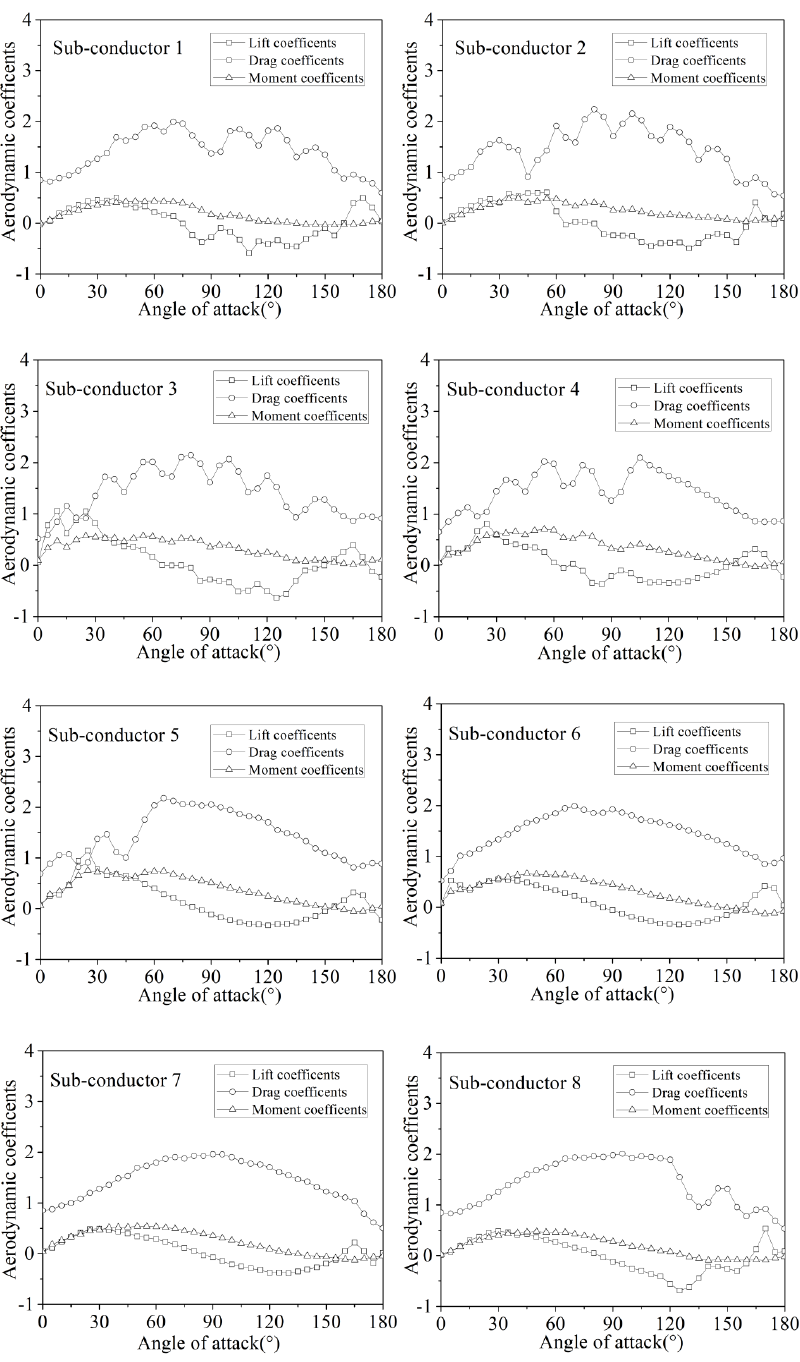
Figure 3. Aerodynamic coefficients of sub-conductors with crescent-shaped ice varying with angle of wind attack (ice thickness: 12 mm). 5. Galloping Characteristics of Conductors of Tower Line System Firstly, the galloping process of three spans of iced eight-bundle conductors with a span length of 200 m and 400 m under wind velocity of 8 m/s are numerically simulated, respectively. Figure 4 shows the spectrum diagram of each span midpoint of the phase C conductor. It can be seen that simulated data of galloping of each span of the conductor is basically stable. 0.0